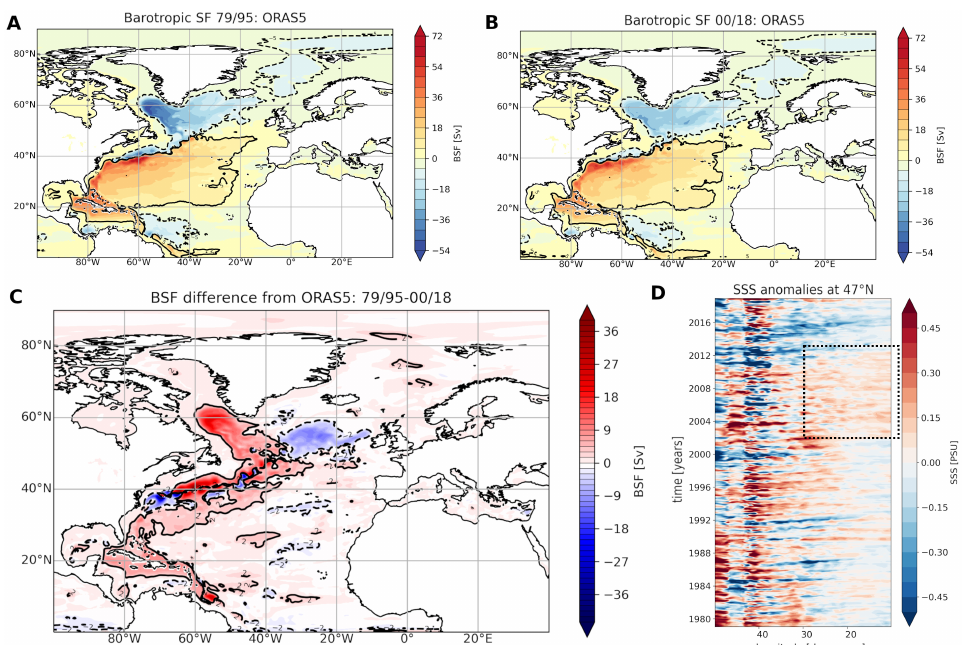
Figure 5. Barotropic stream function (BSF) in the two periods. The GS path is marked by the black contour levels ( − 5 Sv the dashed, 5 Sv the continuous). Positive values indicate clockwise circulation while negative ones counterclockwise circulation. Panel ( A ) shows the average over the period of stronger AMOC, while panel ( B ) shows the average over the weaker AMOC period. Panel ( C ) shows the difference of the modulus of ( A ) minus the modulus of ( B ), in such a way to indicate, regardless of the clockwise or anticlockwise circulation, that the first period has a stronger circulation than the second one. Dashed and continuous contours level in panel ( C ) indicate, respectively, difference of − 2 Sv and 2 Sv. Panel ( D ) shows the longitude–time Hovmoller diagram of salt at 47 ° N, showing the redistribution between the west and the east after the